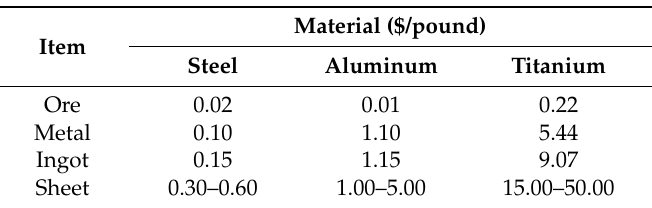
Table 3. Cost of different metals in different forms